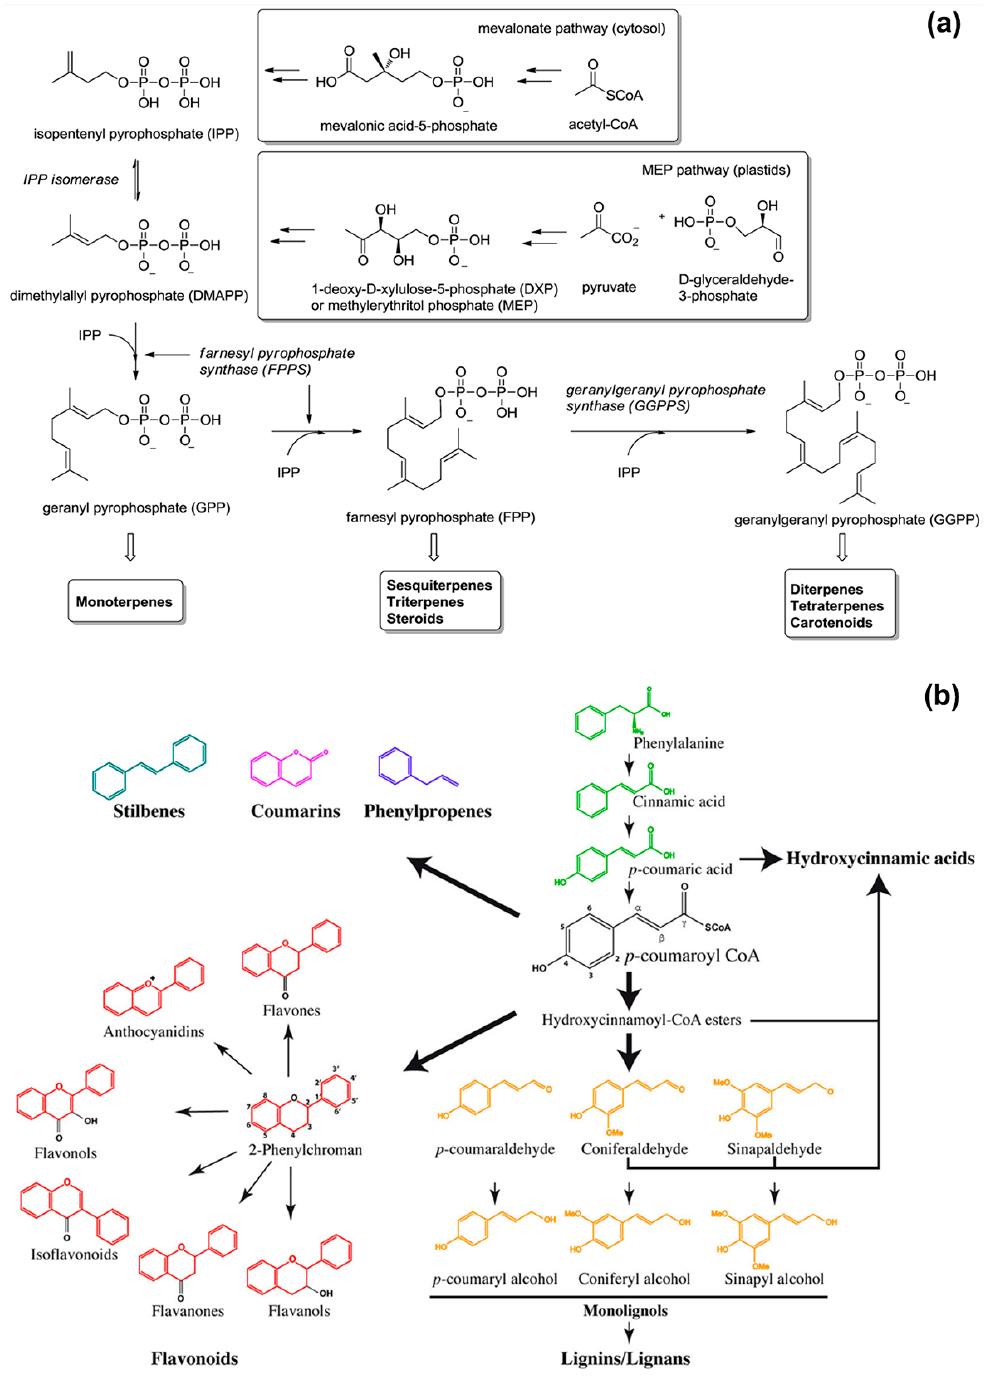
Figure 1. Schematic representations of the biosynthesis of: ( a ) isoprenoids, reproduced from Ref. [20] with permission from the Royal Society of Chemistry; ( b ) phenylpropanoids, reproduced from Ref. [21].